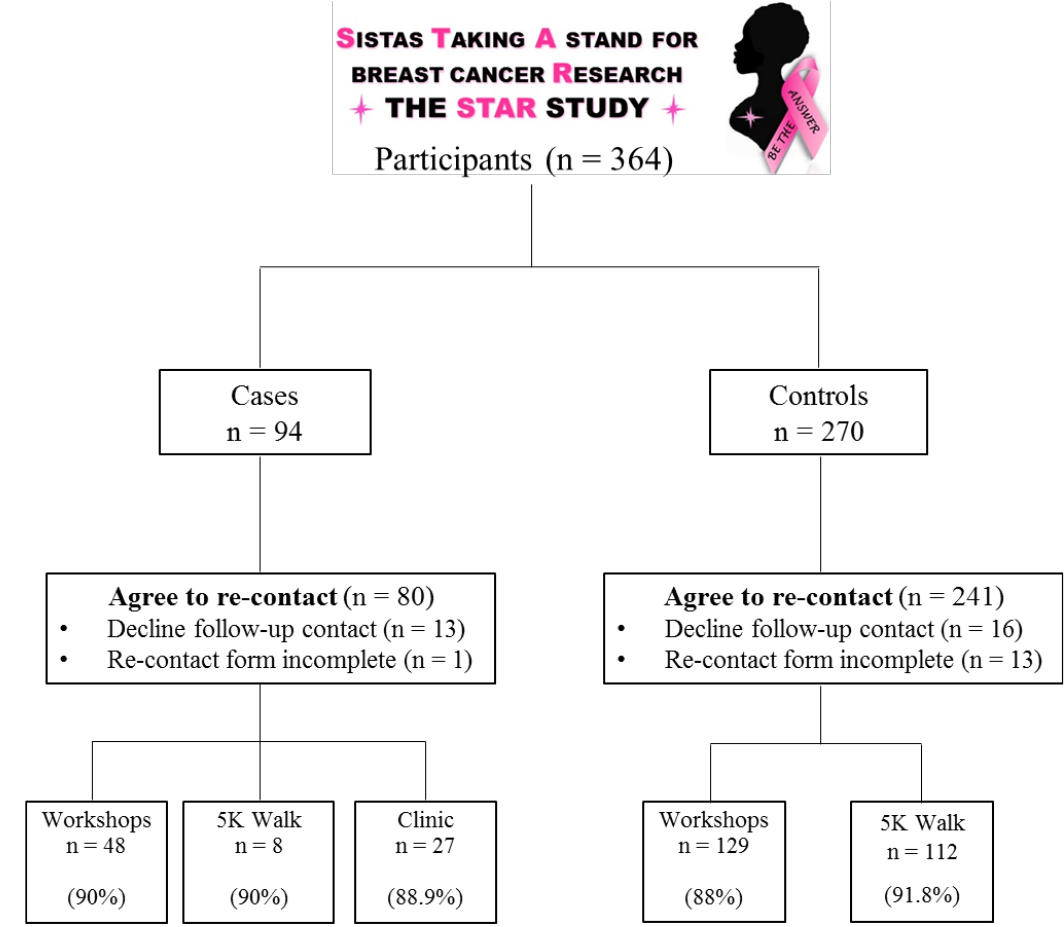
Figure 2. Flow chart of STAR study participant follow-up. The flow chart shows the number ( n ) of participants with breast cancer (cases) and without breast cancer (controls) who provided written consent to be re-contacted after two years from initial consent to participate in the STAR study Percentage (%) represents the percent of participants who agreed to follow-up contact to those who did not grant such permission. Data is reported for each of the recruitment strategies: workshops, 5K walk, or in the clinic.